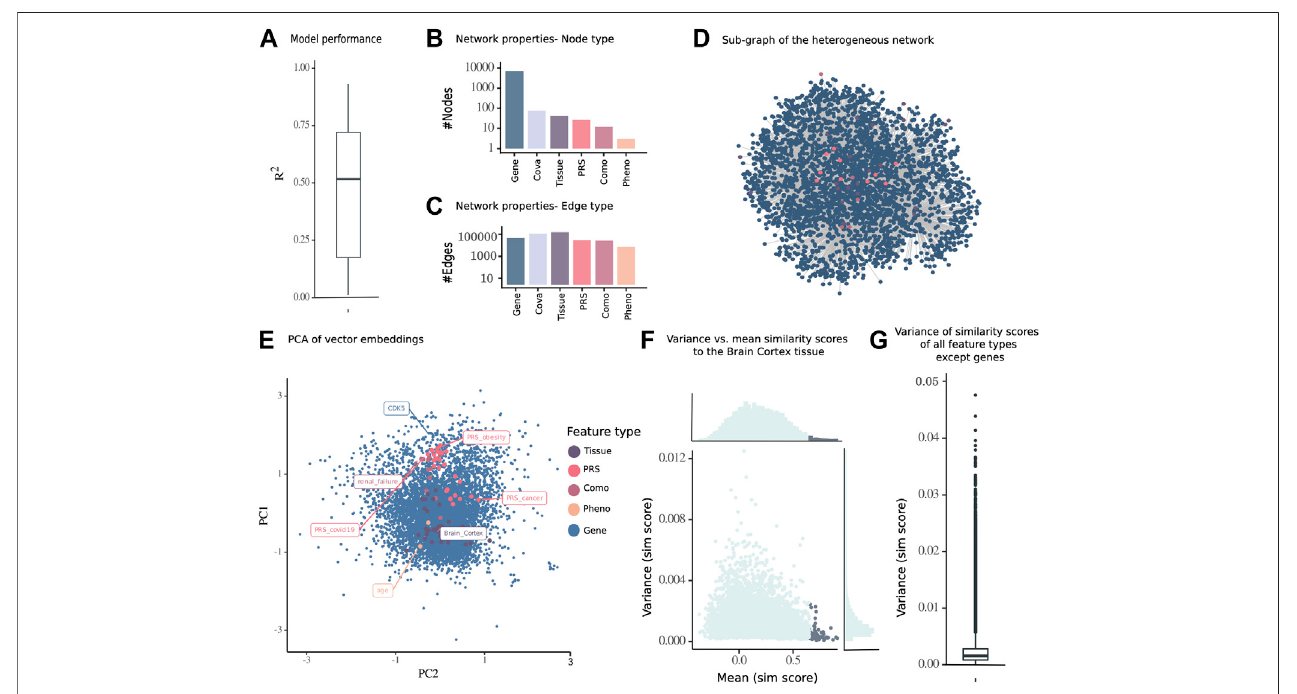
FIGURE 2 | Embedding of a multimodal network consisting of nodes from different data modalities including gene expression, PRS, diseases (comorbidities of COVID-19), phenotypes, and tissues of 13,486 samples from 793 individuals from the GTEx cohort. (A) Subnetwork of the inferred multimodal data. (B) Number of nodes and (C) edges of the complete network. (D) R 2 performance of sparse group lasso gene models from KiMONo, as a quality measure of the edges of the full network. (E) PCA of full network embedding (1 of 100 runs) with PRS for obesity, COVID-19, and cancer, as well as CDK5 gene, brain cortex tissue, and age phenotype highlighted with labels. (F) For one node of interest ( brain cortex ), the highest similarity score across 100 runs was plotted against the variance across 100 runs. The nodes with the highest similarity score to the node of interest ( brain cortex in purple) have a low standard deviation across 100 runs. Marginal density plots displayed to the sides. (G) Variance of similarity scores of all nongene